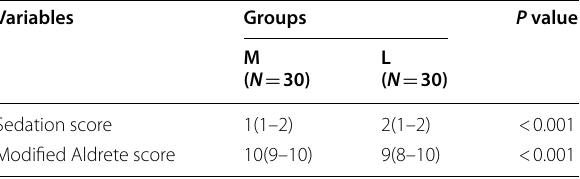
Data are presented as median (range). P value ˂ 0.05 is statistically significant